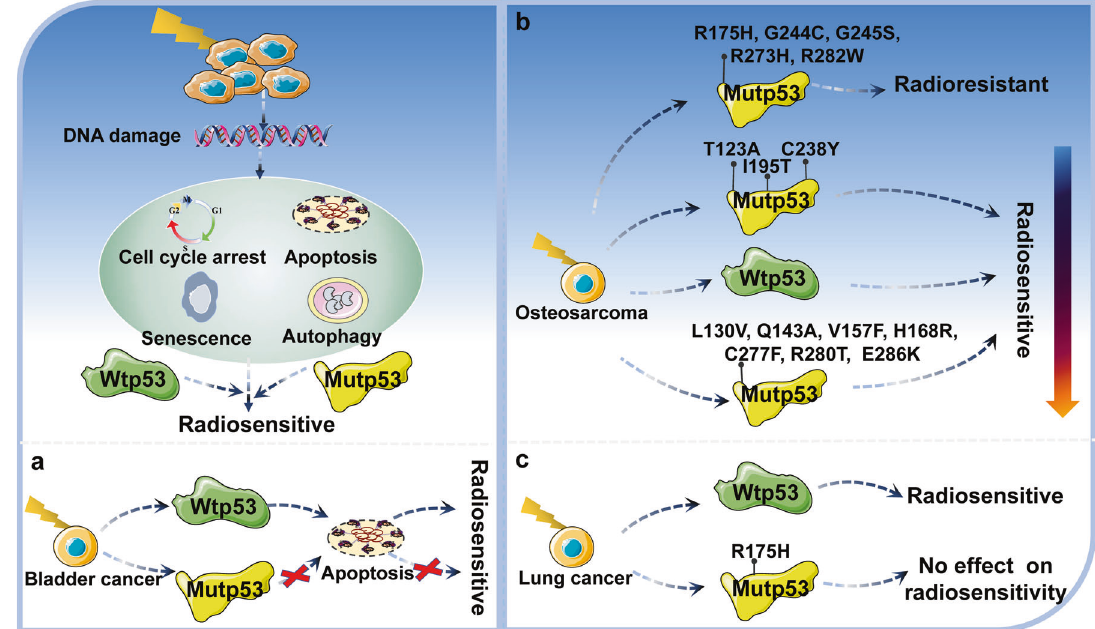
Fig. 6 Schematic representation of the mechanism of mutp53 in radiotherapy. Mutp53 can regulate radiotherapy through various mechanisms. In most cases, expression of mutp53 leads to radiotherapy resistance. However, under a certain context, mutp53 expression can promote radiotherapy sensitivity or have no effect on radiotherapy